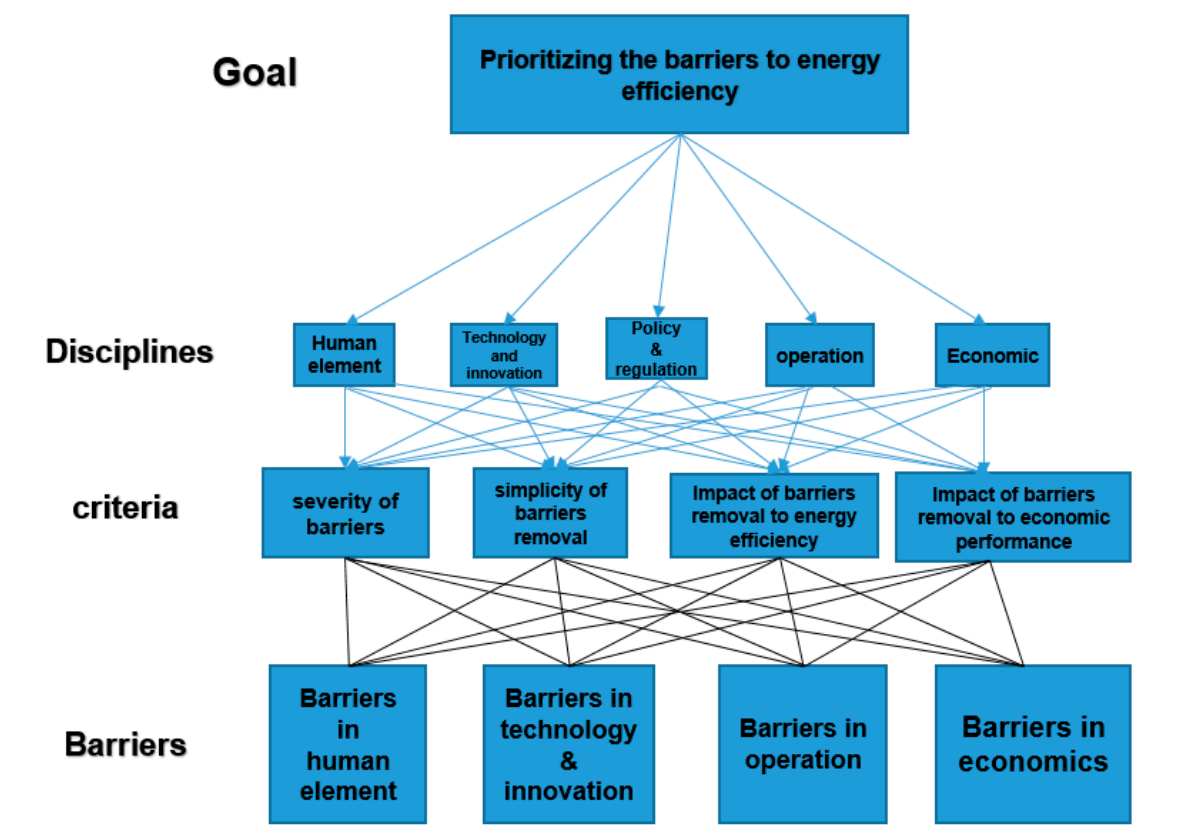
Figure 4. The hierarchical prioritizing of the barriers to energy efficiency by AHP for a shipyard.